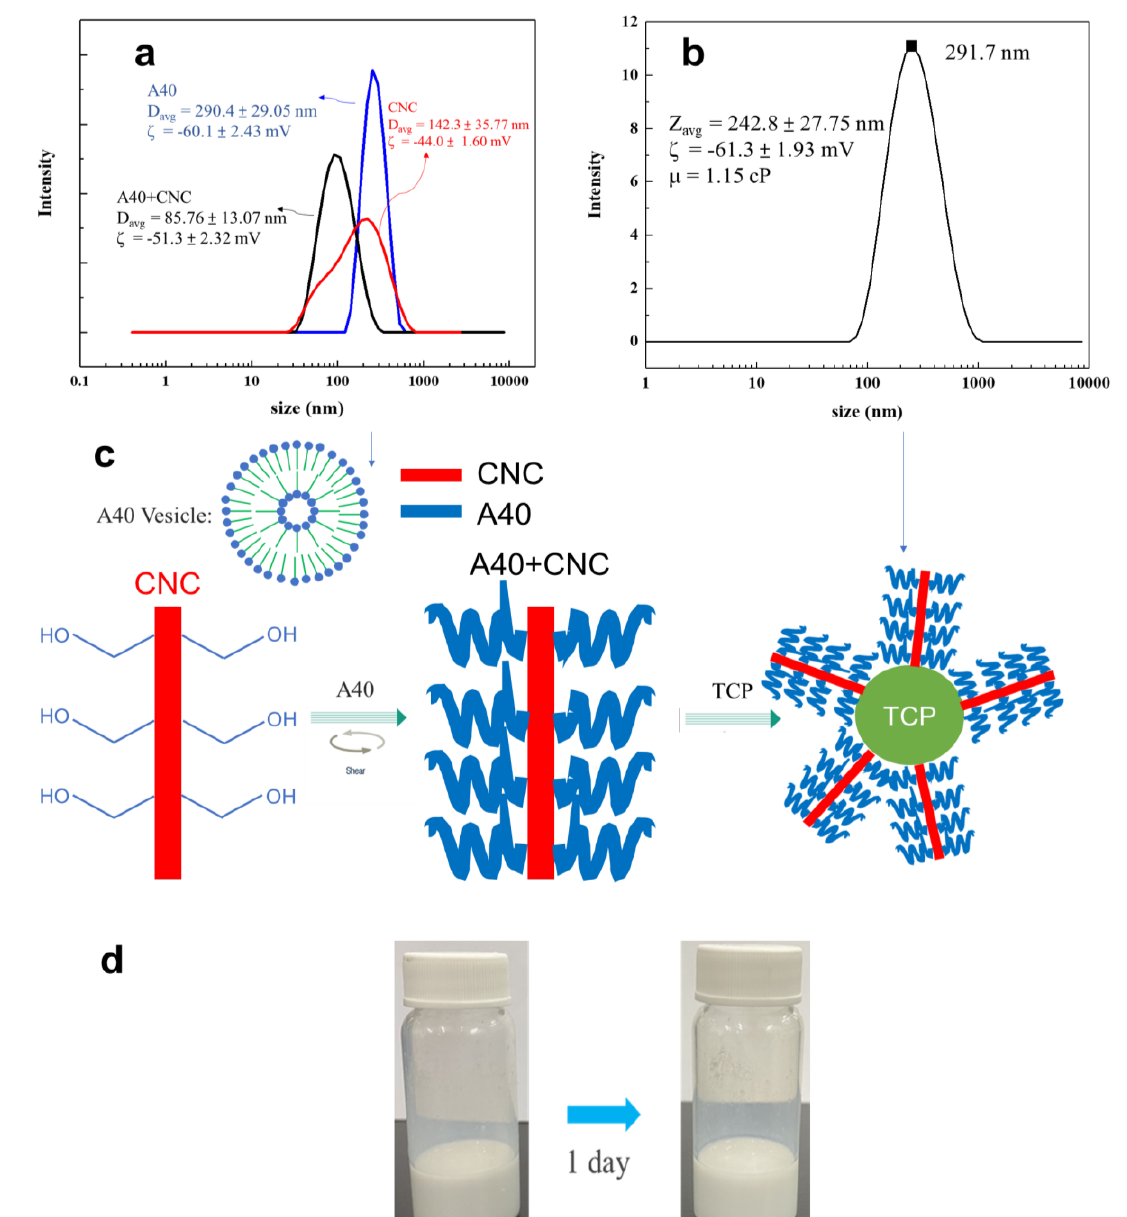
Figure 5. ( a ) Result of the size distribution of 0.3 wt % A40/ 0.1 wt % CNC in water. ( b ) Size distribution for β− TCP suspension with 0.3 wt % A40, 0.1 wt % CNC after ball milling and resuspension. ( c ) Schematic diagram of the interaction between CNC, A40, and TCP. ( d ) Image of β− TCP suspension after one day.